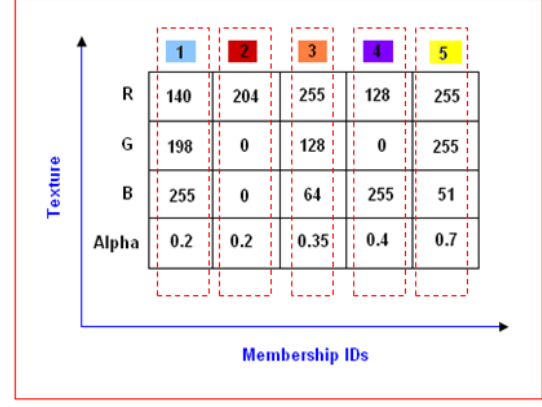
Figure 17. Texture assignment table. Each number and its respective dashed rectangle represent an object ID and its relevant RGBA